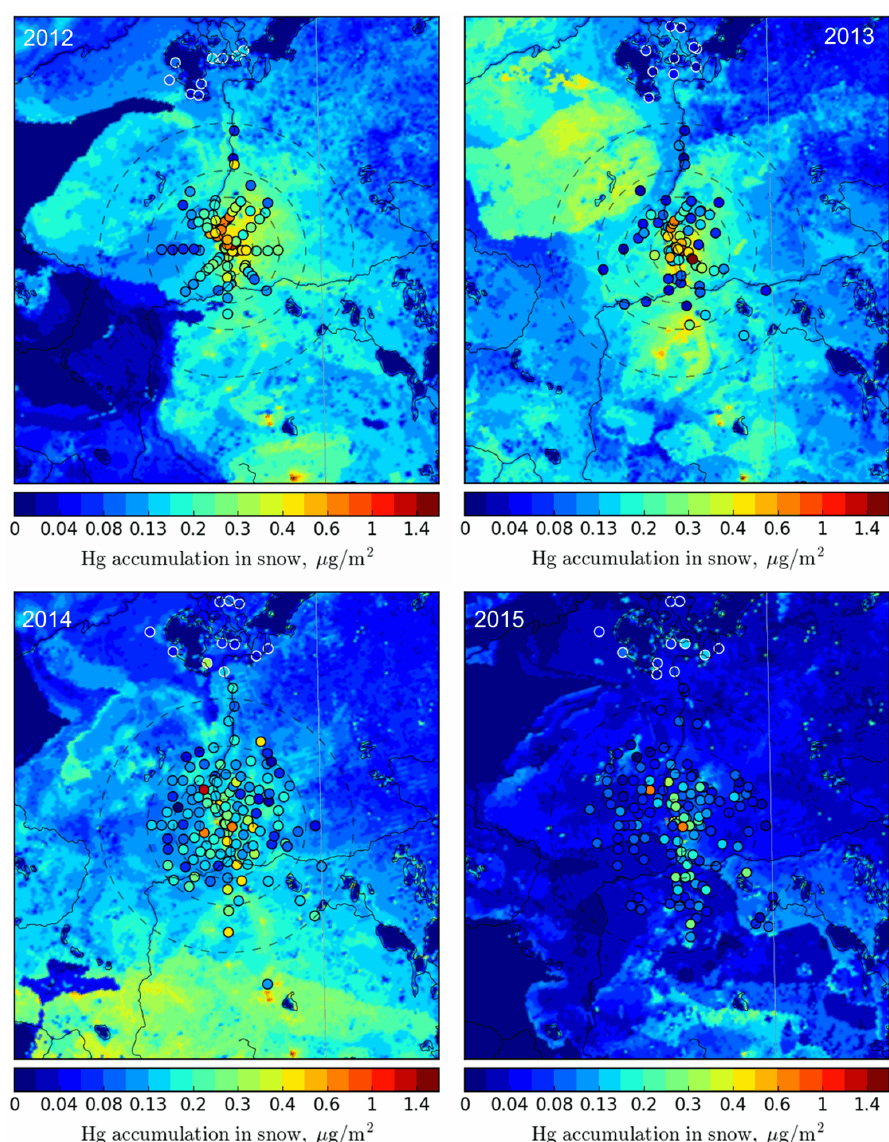
Figure 8. Seasonally accumulated Hg loadings in snow in AOSR from 2012 to 2015: modelled (background map) and observed values (colours in circles). Circle radii: 25, 50, 75,